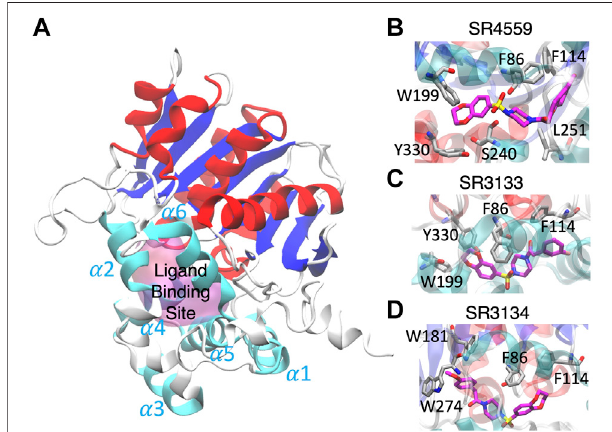
FIGURE 7 | The ligand binding modes of SPZ ligands. (A) SPZ ligands bind to the pocket (magenta) formed by insertion helices, α 2- α 6 (cyan). Red and blue indicate the canonical α helices and β strands, respectively. (B – D) reveal the residues (carbons in gray) interacting with SR4559, SR3133, and SR3134 (carbons in magenta),